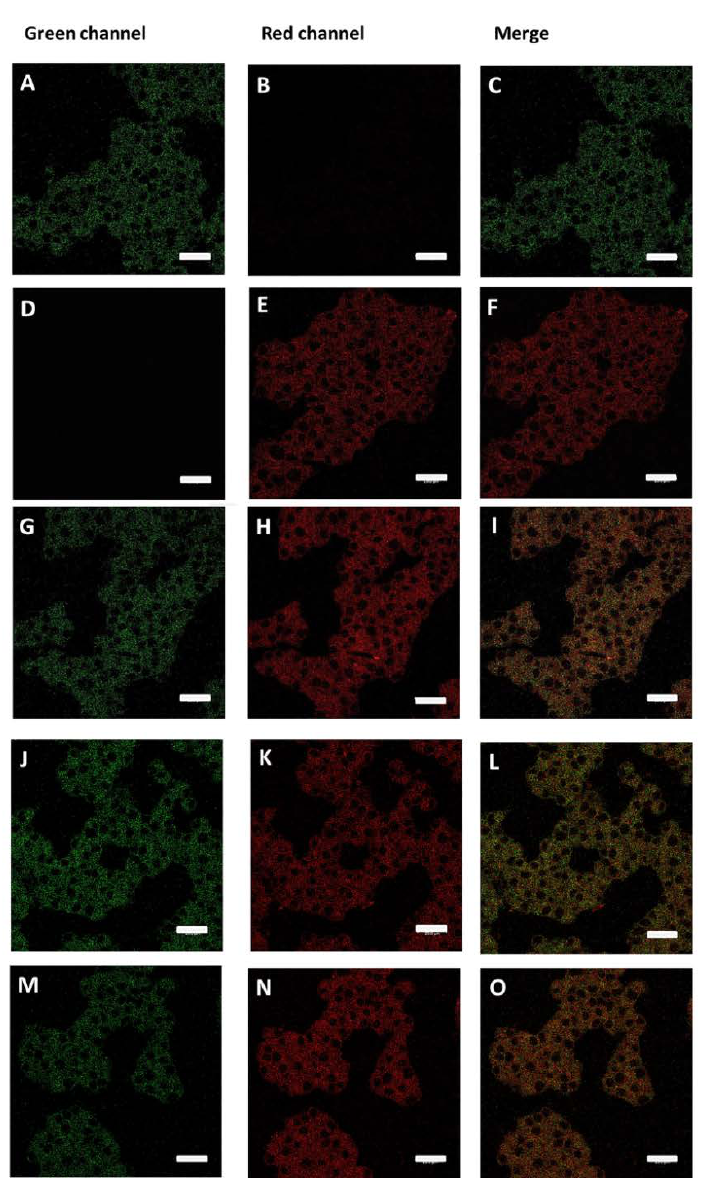
Figure 9. BODIPY-Leu/PS vesicles (green) colocalize with ER-tracker (red). ( A – C ) Langerhans islet β -cells (RIN-m5F cells) treated with BODIPY-Leu/PS vesicles. ( D – F ) Cells treated with ER-tracker. ( G – I ). Cells treated jointly with BODIPY-Leu/PS vesicles and ER-tracker. ( J – L ) Effect of C-native treatment on localization of BODIPY-Leu/PS vesicles and ER-tracker . ( M – O ) Effect of F 23 R peptide treatment on localization of BODIPY-Leu/PS vesicles and ER-tracker. Scale bars correspond to 25 μm.